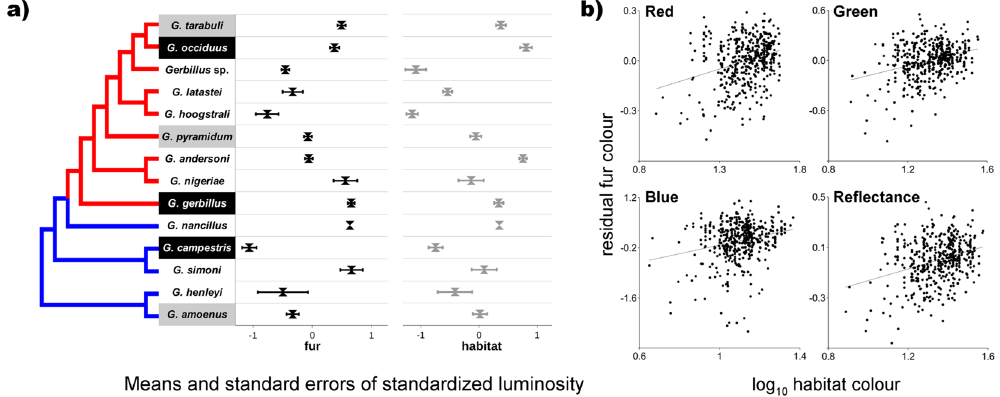
Figure 2. ( a) Phylogenetic hypothesis (tree) derived from molecular data for the Gerbillus species used in this study. The signs of scores for phylogenetic eigenvector (EV1) derived from phylogenetic vector regression (PVR) are depicted on the phylogenetic tree with contrasting pair of colours, of red (negative) and blue (positive scores). Names of species for which signs, or lack of signs, of camouflage adaptation were detected (significant/insignificant relationship between fur and habitat colourations: Table 2) are indicated with black or grey backgrounds, respectively (white background indicate lack of data for comprehensive test). Right panels present means (and standard errors) of log-transformed and standardized fur (black marks, accounted for variation between field/collections specimens) and habitat (grey marks) total reflectance. ( b) The relationship between the residual animal fur and habitat colours for red (R 2 = 0.08, f(x) = 0.30x − 0.44), green (R 2 = 0.10, f(x) = 0.58x − 0.76) and blue (R 2 = 0.06, f(x) = 1.21x − 1.33) colour spectrum, and total reflectance (R 2 = 0.10, f(x) = 0.46x − 0.63). Residuals were calculated from linear models including animal fur colours as dependent